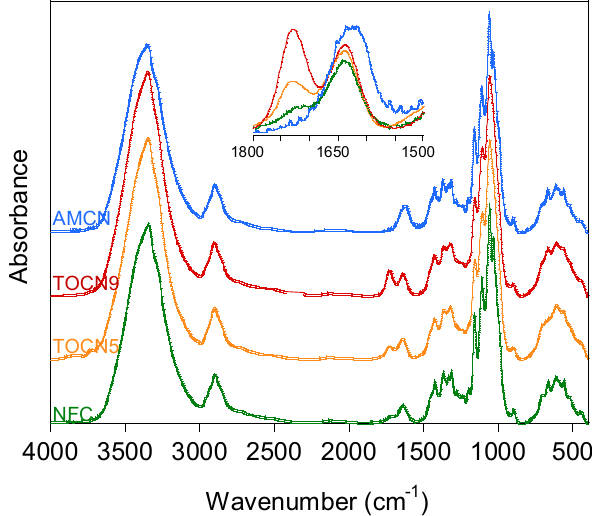
Figure 1. FT-IR spectra in absorbance of the unmodified nanofibrillated cellulose (NFC), TEMPO-oxidized NFC (TOCN5 and TOCN9) and amine-modified NFC (AMCN). The inset shows the 1800–1500 cm − 1 region.